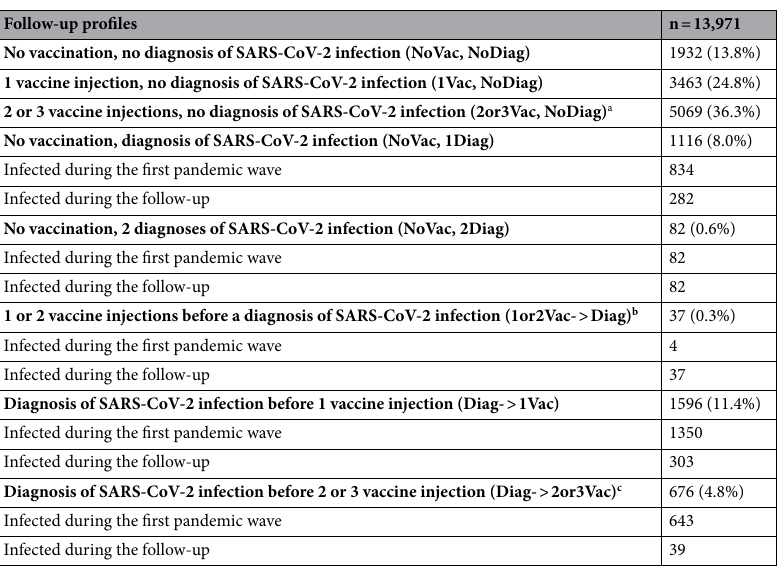
Table 1. Follow-up profiles. a 23 received 3 vaccine injections. b 29 received 1 vaccine injection, 8 received 2 vaccine injections. c 5 received 3 vaccine